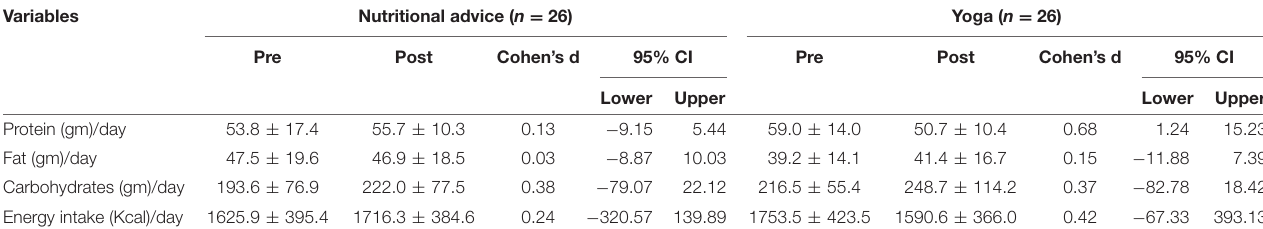
TABLE 5 | Estimated energy intake/day based on 24h diet recall questionnaire. Variables Nutritional advice ( n =